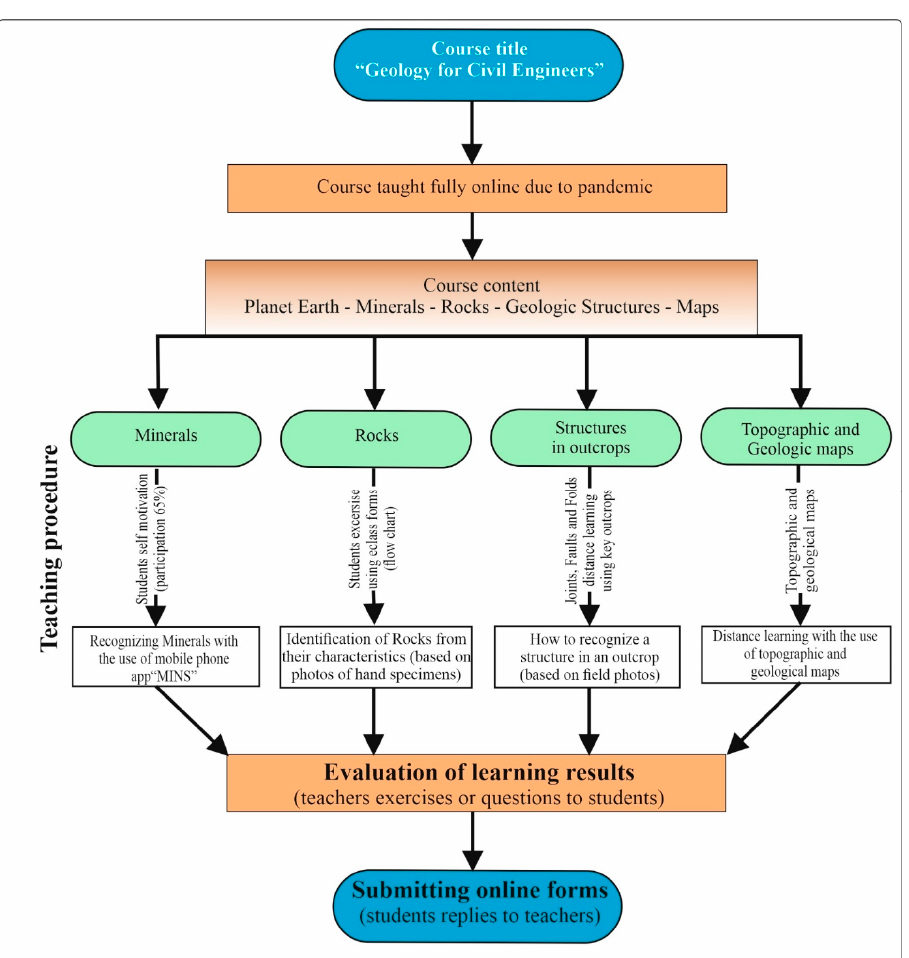
Figure 1. Flow chart of teaching geology under DL.